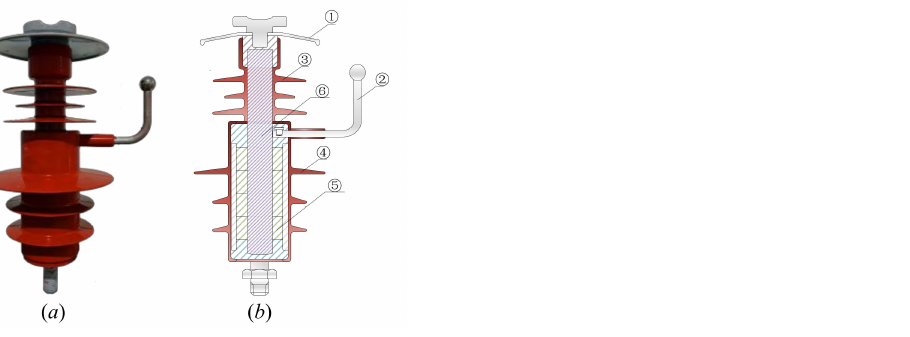
Figure 1. Thenovellightningprotectioncompositeinsulator: ( a )Physicaldrawing; ( b )Sectionalillustration. Table 1. Geometric parameters of the